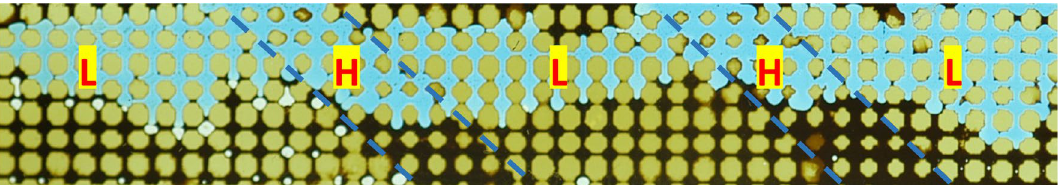
Fig. 12 Polymer front movement in tilted-stripped layered flow pattern (high- and low-permeable layers alternate each other; injection from right side; blue dashed lines are zone borders; L low-permeable zone, H high-permeable zone)